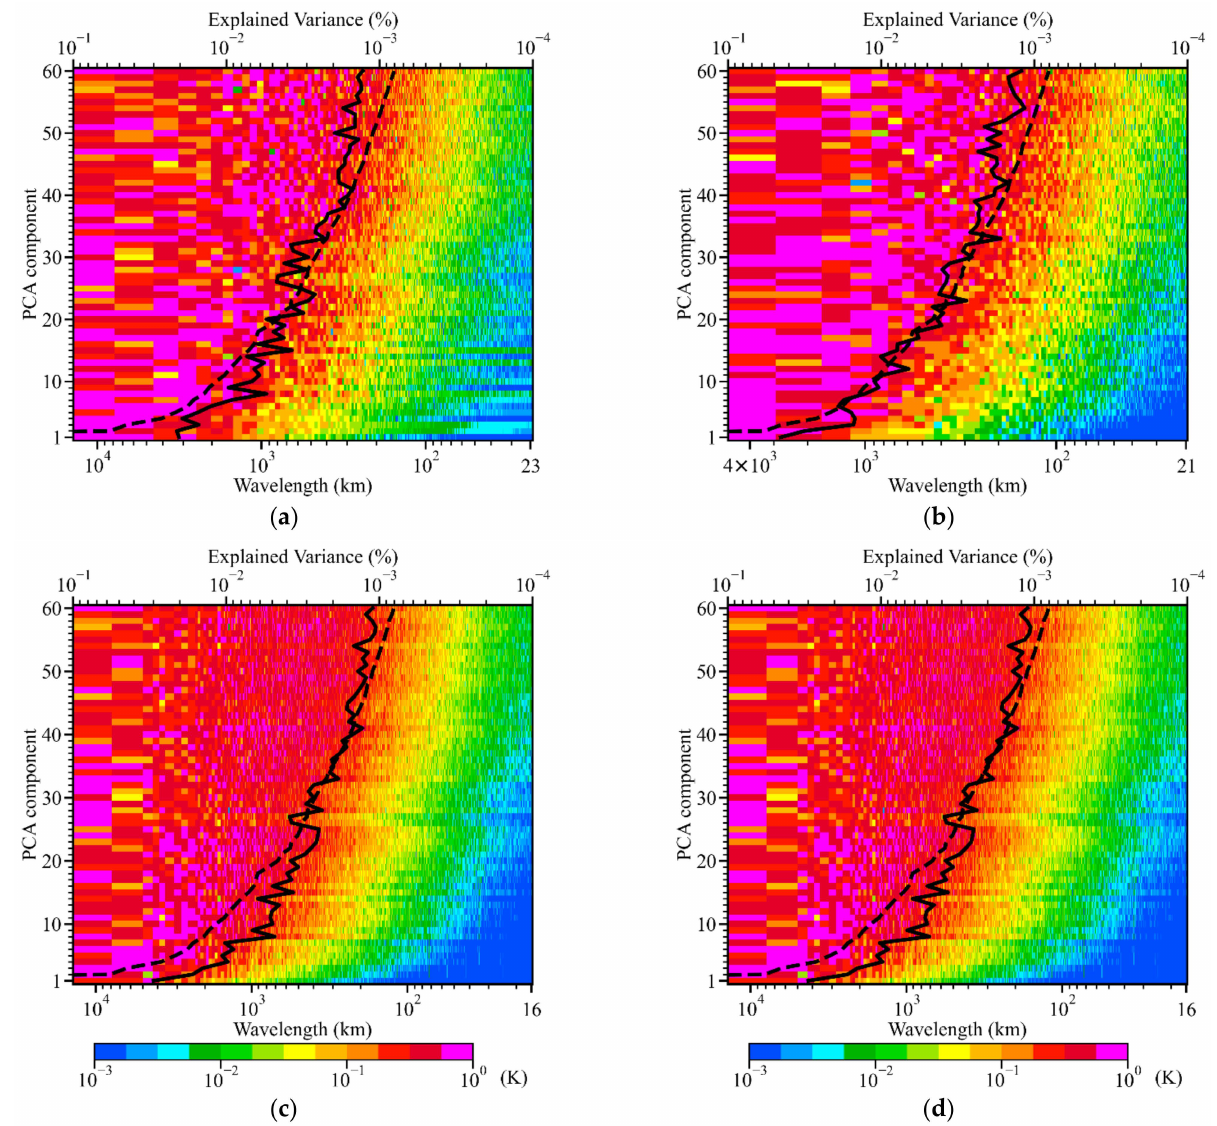
→ → e i u iT , i = 1, . . . , 60) in ( a ) zonal